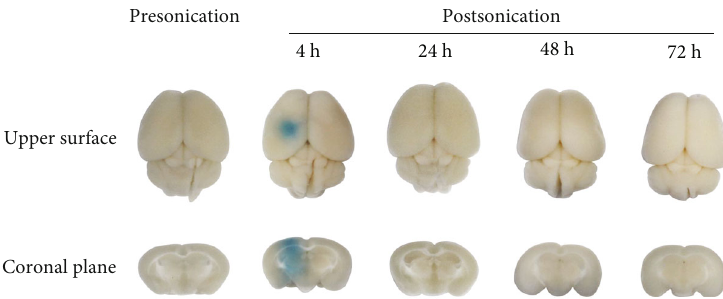
Figure 4: EB staining of mouse brain before/after FUS sonication. Obvious EB leakage is shown in the fi gure at 4 h after FUS sonication, while there is no EB staining presonication and at 24, 48, and 72h